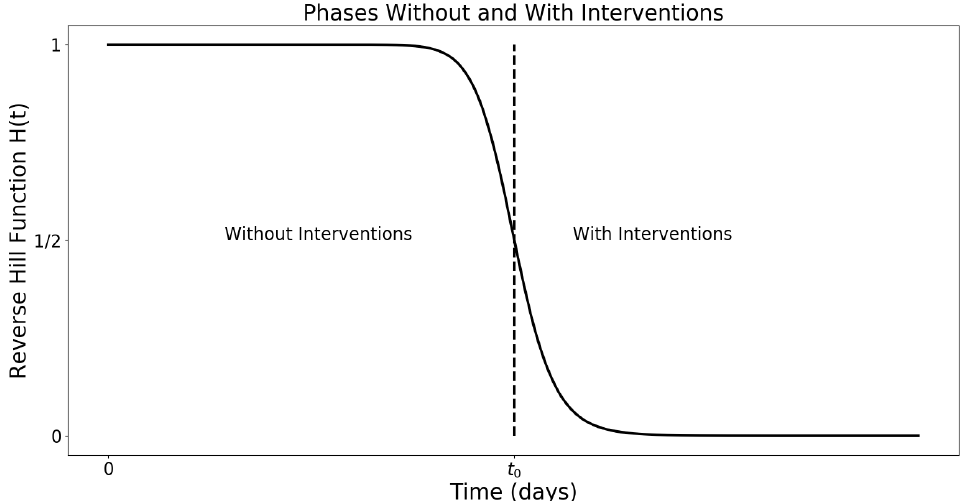
Figure A7. Reverse Hill Function—Phases of outbreaks without interventions and with interventions. The horizontal axis represents time in days, and the vertical axis represents the values of the reversed Hill function in (A9). The disease progresses without interventions when time t < t 0 and the ˜ β x = β x for all x ; the disease spreads with interventions when t > t 0 and the ˜ β x (cid:39) 0.